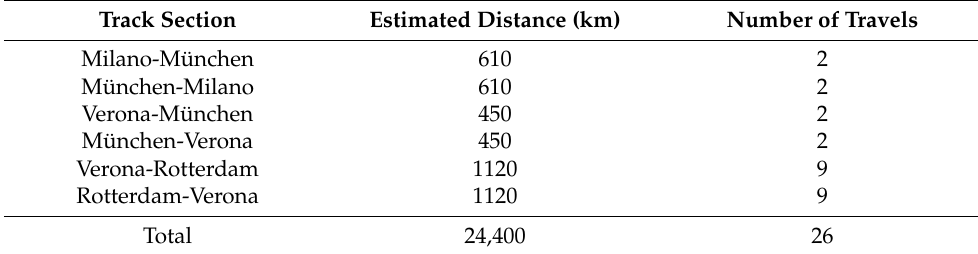
Table 4. Travels during field test.